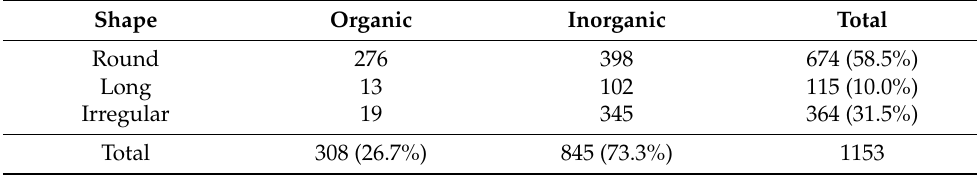
Table 3. Frequency of nasal foreign bodies according to shape and organic/inorganic